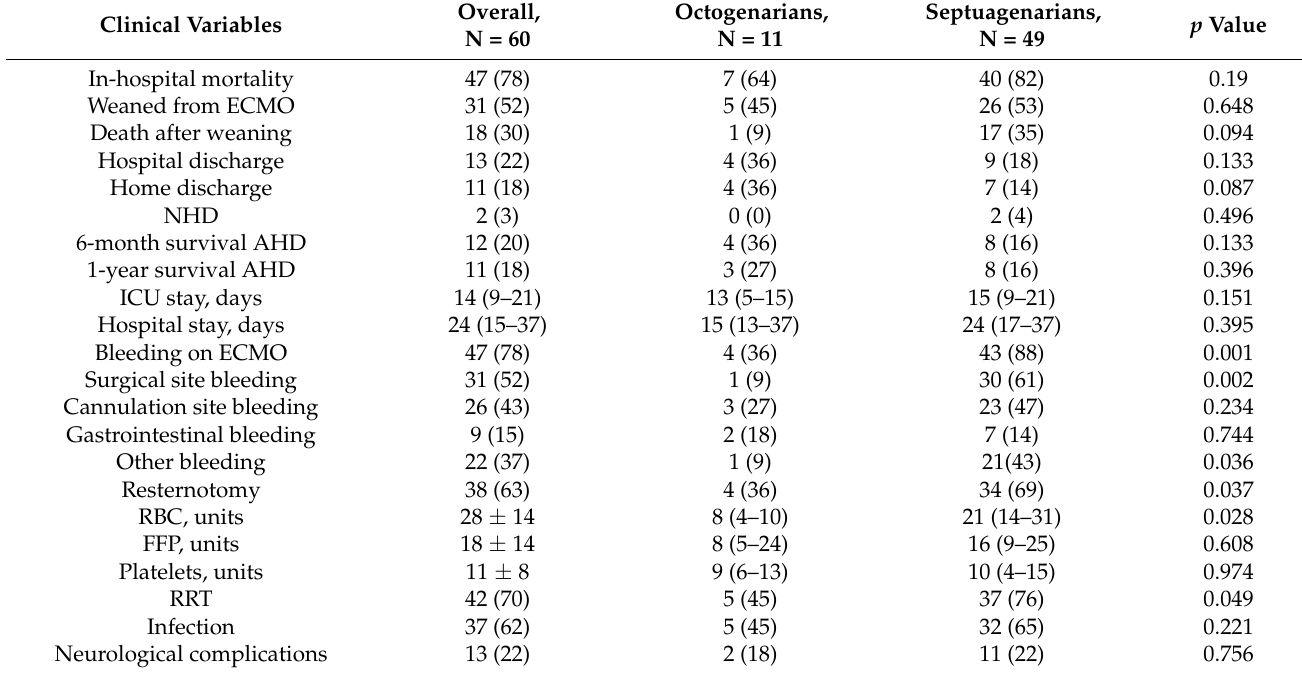
Table 4. Patient outcomes and complications.